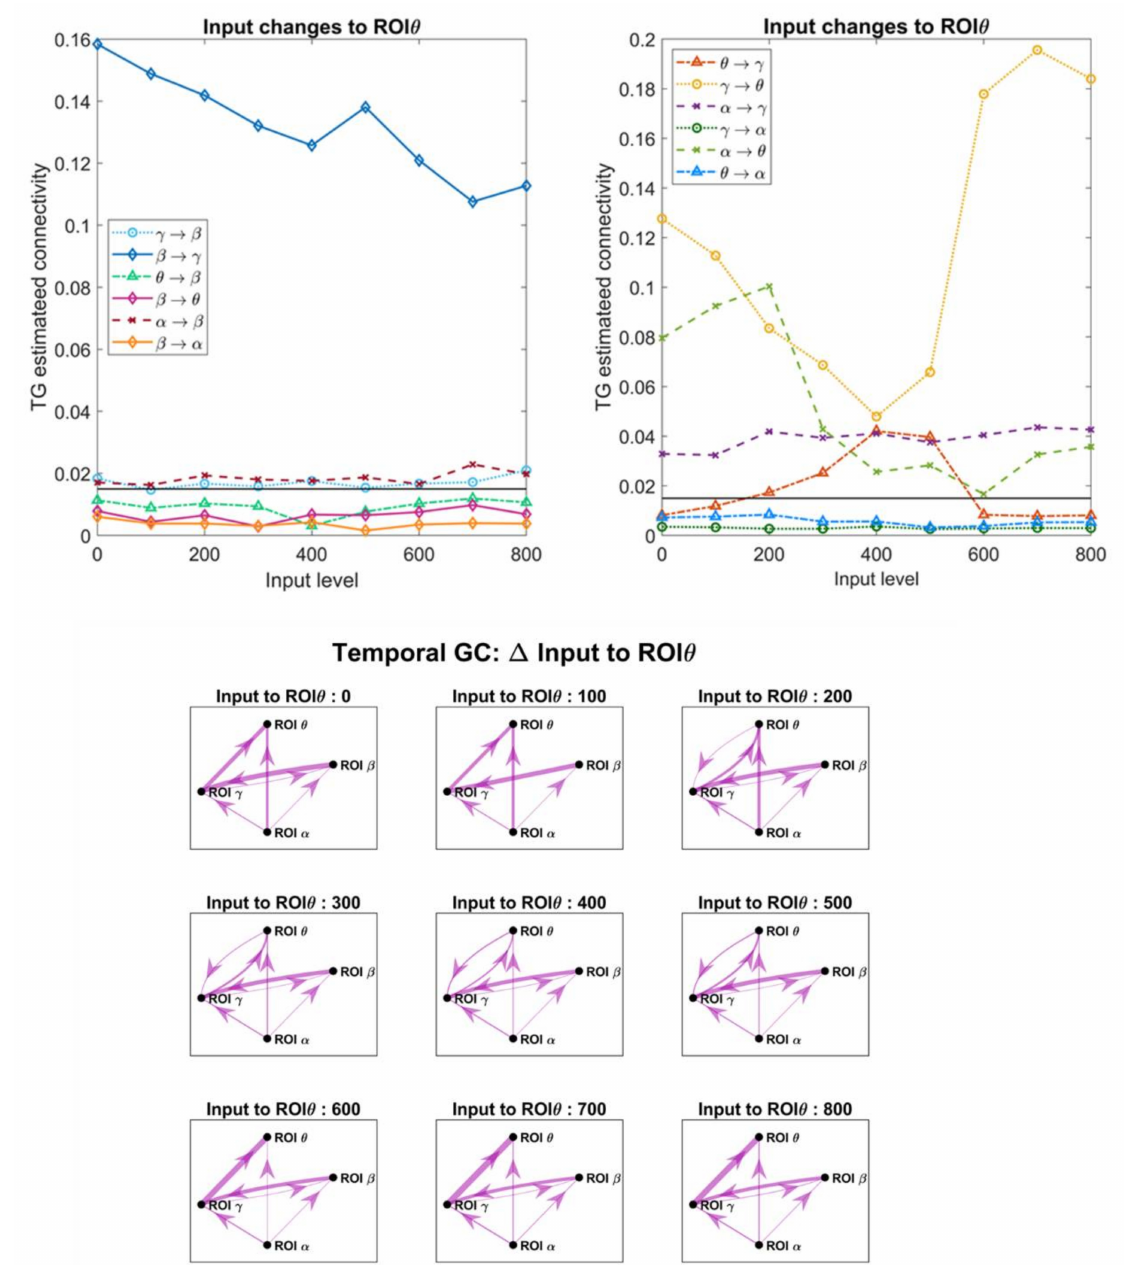
Figure 9. Upper panels: Values of connectivity among the ROIs estimated with the temporal Granger causality, with reference to the network in Figure 2A, when the input to pyramidal neurons in ROI θ was progressively varied from 0 to 800, as in the x -axis, and all other inputs and connections were maintained at the basal value, as in Figure 2A. It is worth noting the strong effect that the input change has on the connections which involve the ROI θ . Bottom panels: connectivity graphs obtained from the estimates using a threshold as low as 0.015 (the threshold is depicted as a horizontal black line in the upper